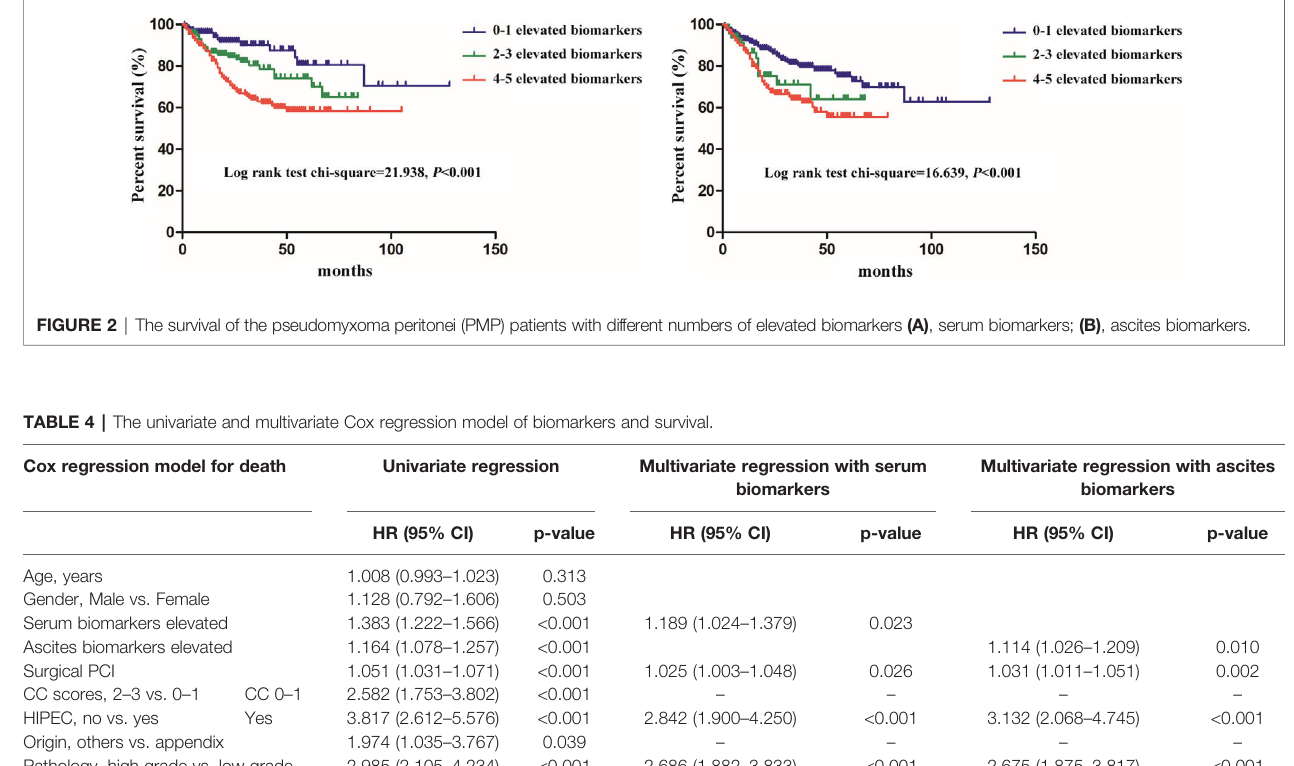
Multivariate regression with ascites biomarkers biomarkers